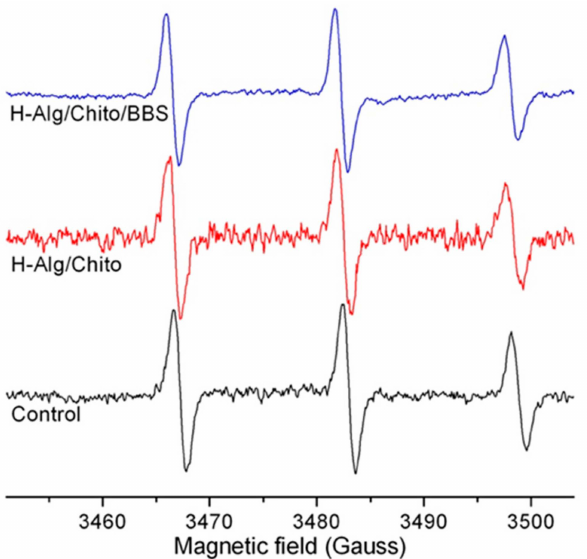
Figure 5. Electron paramagnetic resonance EPR spectra of 5-doxylstearic acid at RT in di ff erent environment (intensities were normalized to the central line in order to better compare the